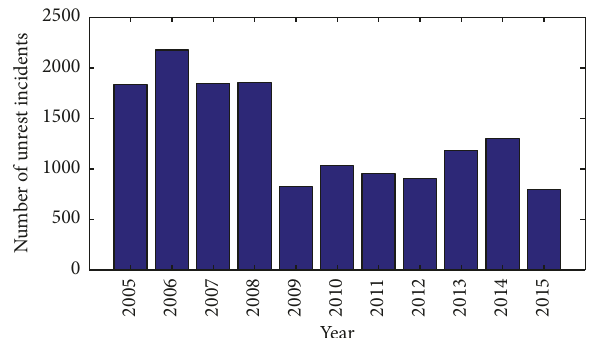
Figure 1: Number of unrest incidents in the four southern provinces of Thailand (Pattani, Yala, Narathiwat, and Songkla) from 2005 to 2015.